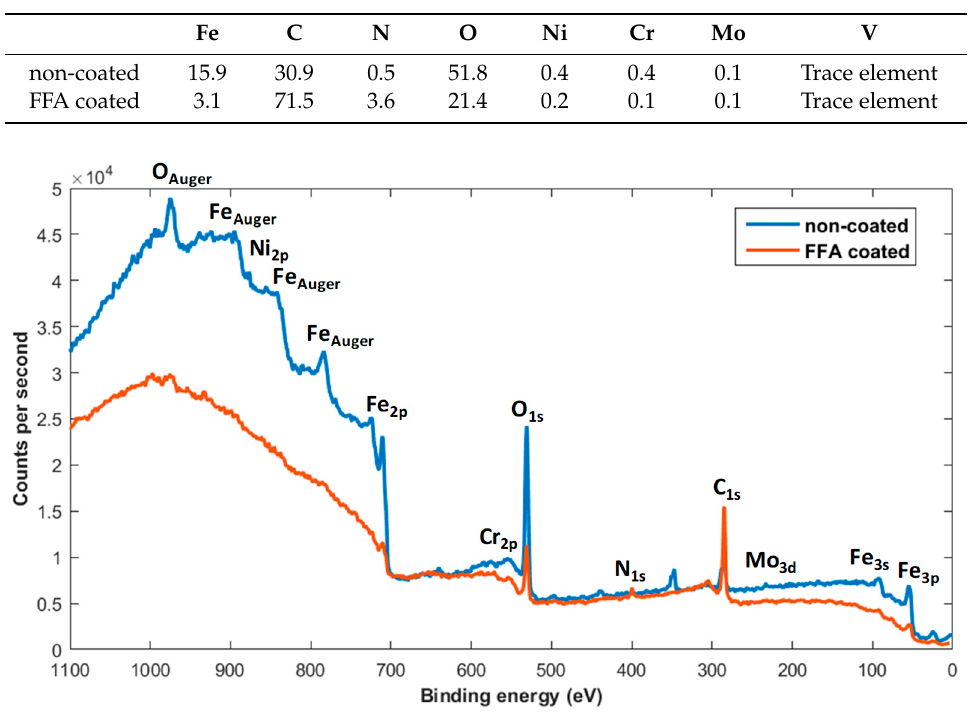
Table 2. Surface atomic composition of non-coated and FFA-coated NiCrMoV steam turbine steel in at.%.